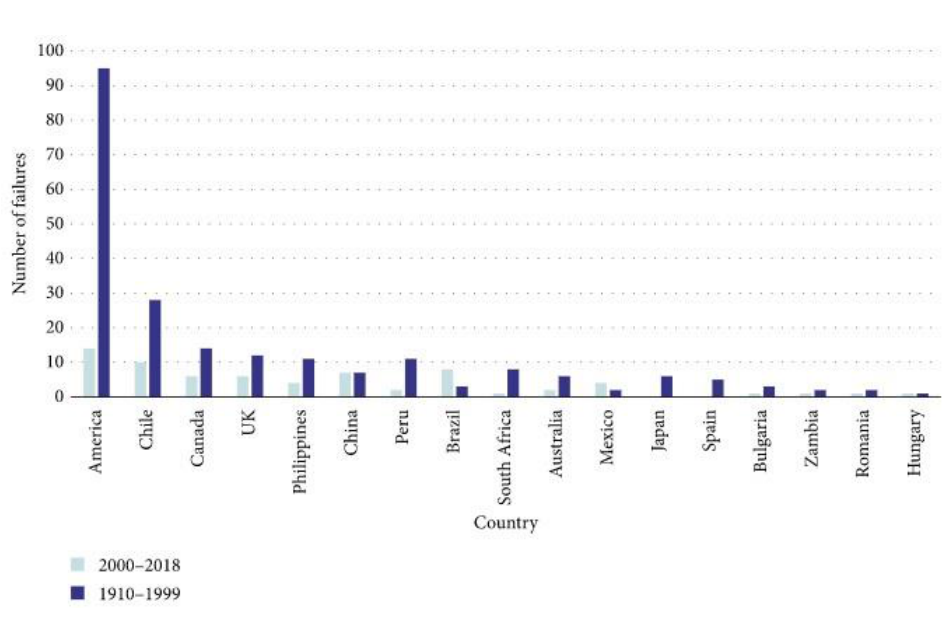
Figure 6. Number of accidents involving tailings dam failures in several countries from 1910 to 2018 [81].